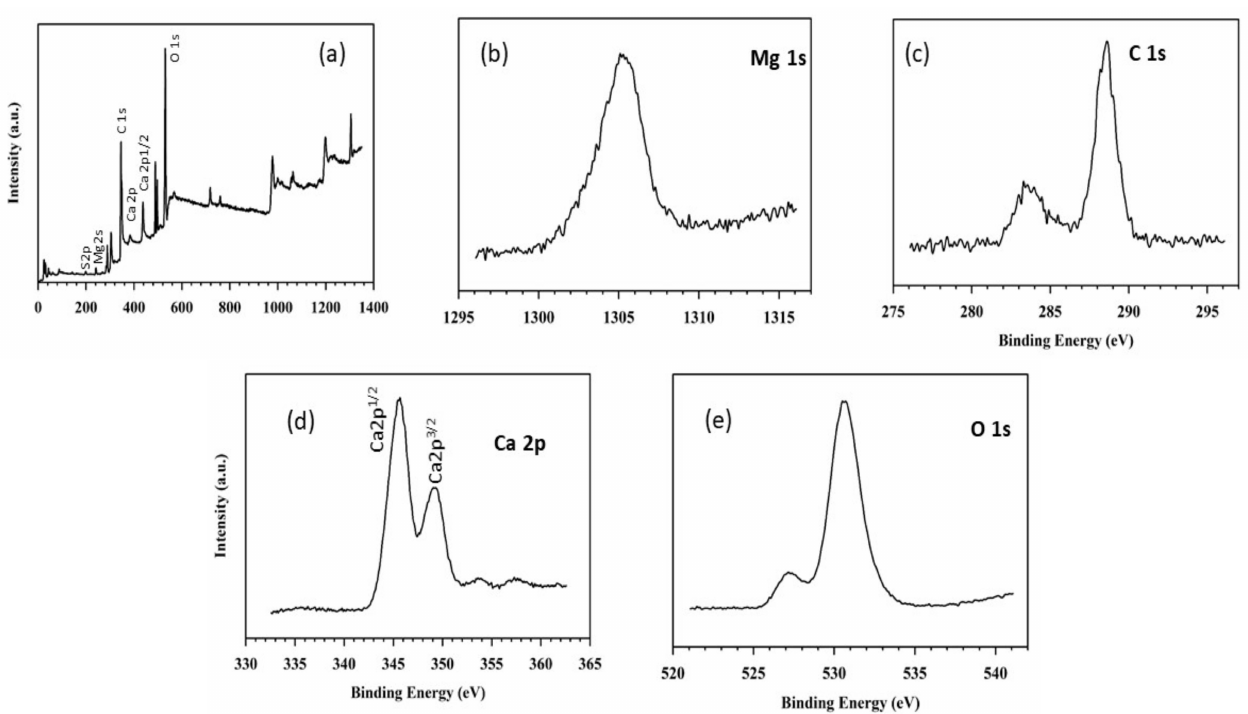
Figure 7. XPS spectra of as-synthesized 10-MCC: ( a ) survey spectrum, ( b ) Mg 1s region; ( c ) C 1s region ( d ) Ca 3p region, and ( e ) O1s